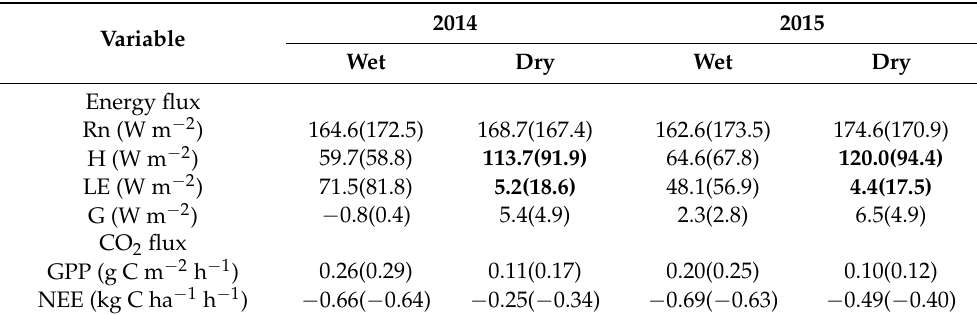
Table 4. Mean value of observed and simulated (values in parenthesis) energy balance components gross primary production (GPP) and net ecosystem CO 2 exchange (NEE) during the wet season and dry season for the years 2014 and 2015.